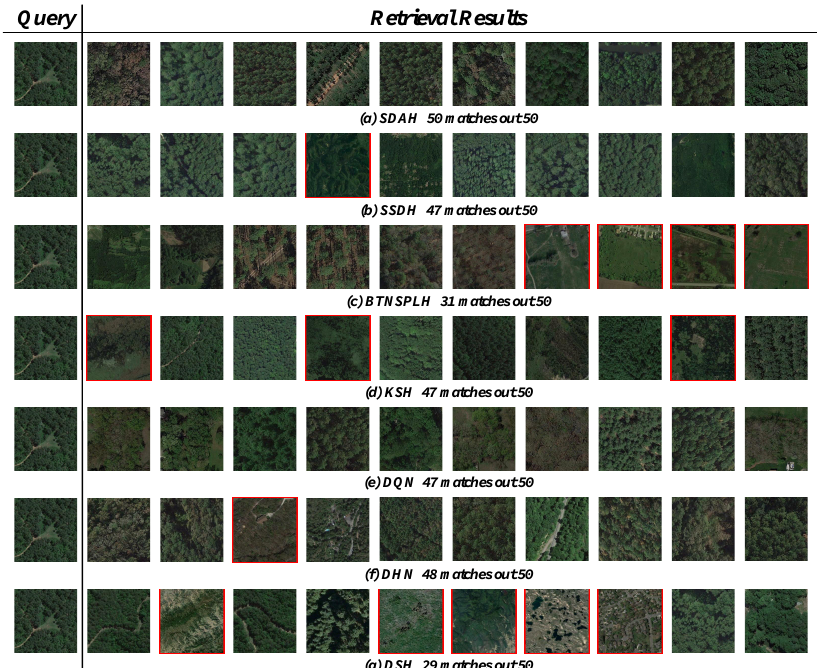
Figure 19. Retrieval examples of “Forest” within NWPU dataset based on the 128 bits hash codes learned by the different hash learning methods. The first images in each row are the queries. The remaining images in each row are the Top 10 retrieval results. The incorrect results are tagged in red, and the number of correct results among Top 50 retrieval images is provided for